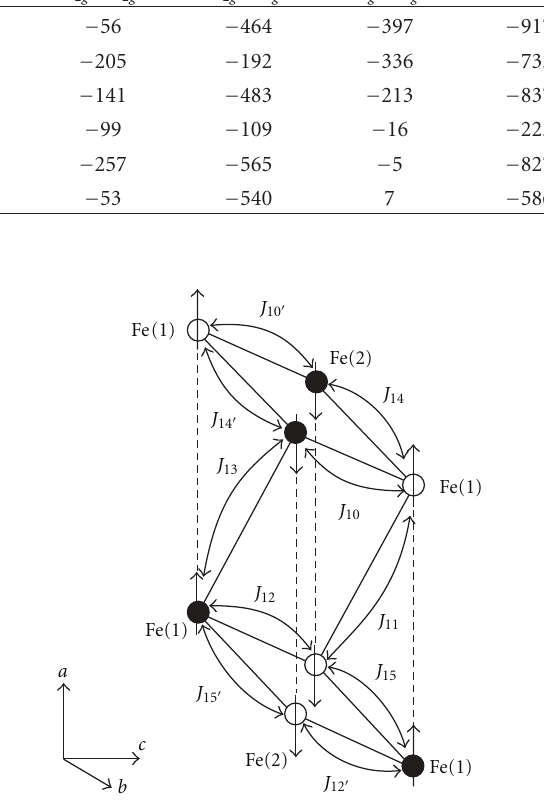
Figure 20: The sketch of the arrangement of interribbon exchange interaction parameters [211]. Open circles correspond to Fe 3+ , while Fe 2+ cations are noted by the closed circles. The spin moment direction on each Fe site is shown by an arrow. Note that J i (cid:2) exchange parameters presented here have the same total values as J i , while subband contributions are di ff